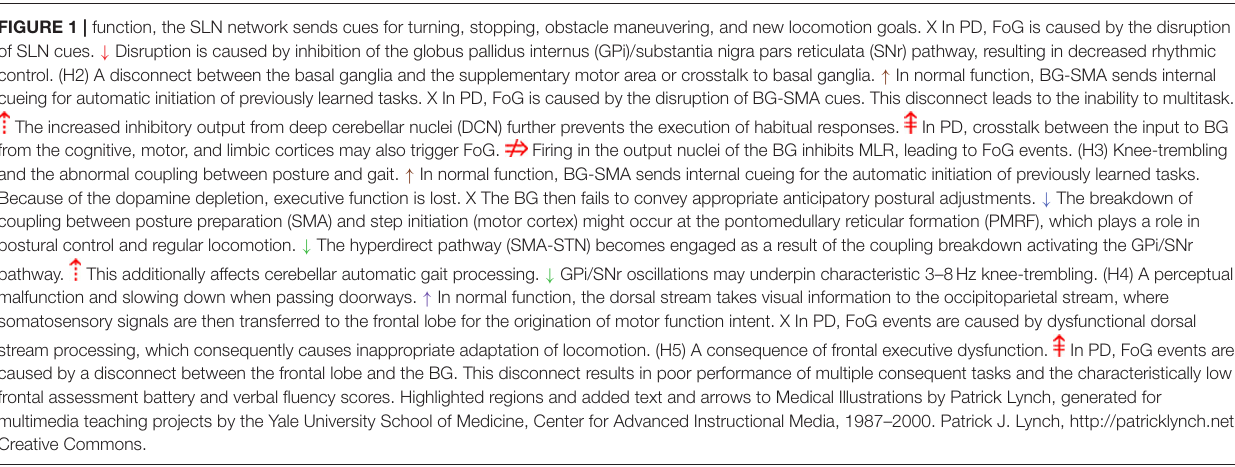
FIGURE 1 | function, the SLN network sends cues for turning, stopping, obstacle maneuvering, and new locomotion goals. X In PD, FoG is caused by the disruption of SLN cues. ↓ Disruption is caused by inhibition of the globus pallidus internus (GPi)/substantia nigra pars reticulata (SNr) pathway, resulting in decreased rhythmic control. (H2) A disconnect between the basal ganglia and the supplementary motor area or crosstalk to basal ganglia. ↑ In normal function, BG-SMA sends internal cueing for automatic initiation of previously learned tasks. X In PD, FoG is caused by the disruption of BG-SMA cues. This disconnect leads to the inability to multitask. The increased inhibitory output from deep cerebellar nuclei (DCN) further prevents the execution of habitual responses. In PD, crosstalk between the input to BG from the cognitive, motor, and limbic cortices may also trigger FoG. Firing in the output nuclei of the BG inhibits MLR, leading to FoG events. (H3) Knee-trembling and the abnormal coupling between posture and gait. ↑ In normal function, BG-SMA sends internal cueing for the automatic initiation of previously learned tasks. Because of the dopamine depletion, executive function is lost. X The BG then fails to convey appropriate anticipatory postural adjustments. ↓ The breakdown of coupling between posture preparation (SMA) and step initiation (motor cortex) might occur at the pontomedullary reticular formation (PMRF), which plays a role in postural control and regular locomotion. ↓ The hyperdirect pathway (SMA-STN) becomes engaged as a result of the coupling breakdown activating the GPi/SNr pathway. This additionally affects cerebellar automatic gait processing. ↓ GPi/SNr oscillations may underpin characteristic 3–8Hz knee-trembling. (H4) A perceptual malfunction and slowing down when passing doorways. ↑ In normal function, the dorsal stream takes visual information to the occipitoparietal stream, where somatosensory signals are then transferred to the frontal lobe for the origination of motor function intent. X In PD, FoG events are caused by dysfunctional dorsal stream processing, which consequently causes inappropriate adaptation of locomotion. (H5) A consequence of frontal executive dysfunction. In PD, FoG events are caused by a disconnect between the frontal lobe and the BG. This disconnect results in poor performance of multiple consequent tasks and the characteristically low frontal assessment battery and verbal fluency scores. Highlighted regions and added text and arrows to Medical Illustrations by Patrick Lynch, generated for multimedia teaching projects by the Yale University School of Medicine, Center for Advanced Instructional Media, 1987–2000. Patrick J. Lynch, http://patricklynch.net Creative